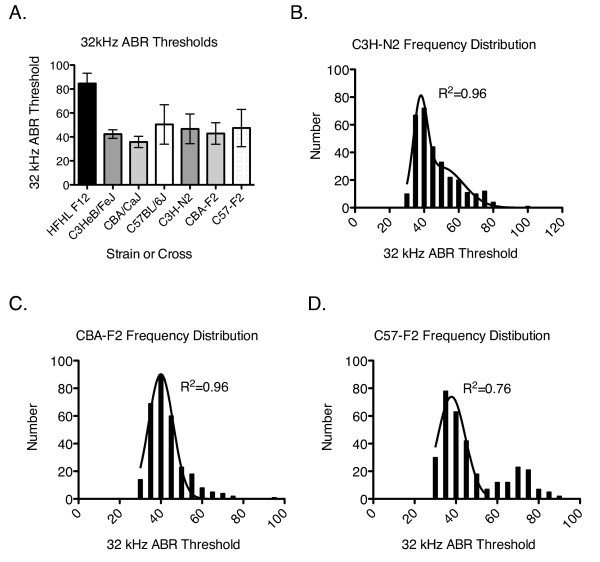
Auditory brainstem responses. (A) ABR thresholds in dB SPL for 32 kHz pure tone stimuli in the parental and second-generation (N2 and F2) populations. (B-D) Threshold distributions for (B) C3H-N2, (C) CBA-F2, and (D) C57-F2 populations. (B) The C3H-N2 frequency distribution was produced using data presented previously [10] and is reproduced here for clarification and presentation purposes. This distribution is best fit by the sum of two Gaussian distributions (Goodness-of-fit R2 = 0.96, n = 306). (C) The CBA-F2 frequency distribution was fitted using a Gaussian distribution (Goodness-of fit R2 = 0.96, n = 294). (D) The C57-F2 frequency distribution appears to be bi-modal but only the first peak of the curve could be fitted initially (Goodness-of-fit R2 = 0.76, n = 320). When the data from individuals with 32 kHz ABR thresholds 60 dB SPL or greater was analyzed separately, the second peak fit a Gaussian distribution (Goodness-of-fit R2 = 0.85, n = 82).